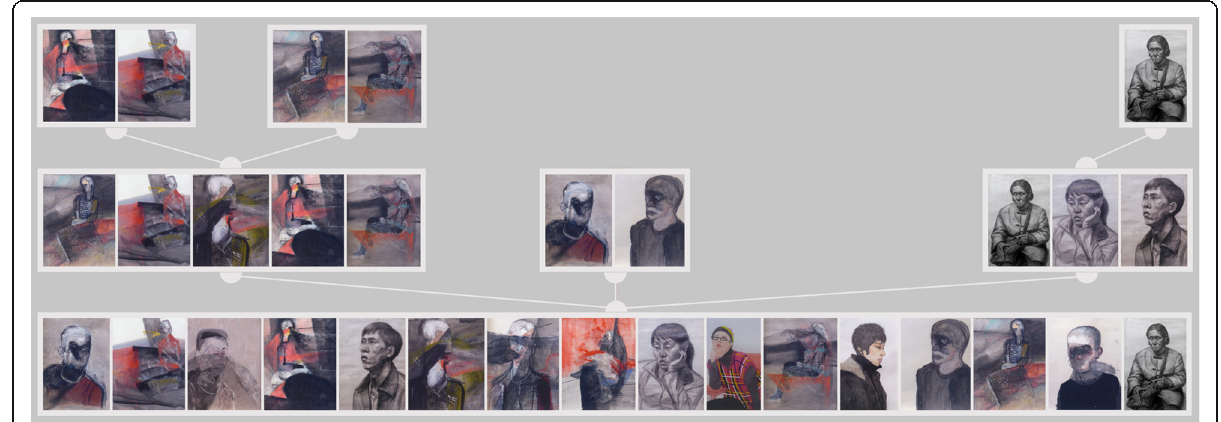
Fig. 10 Examples of hyponymy; artist: Weiran Wang